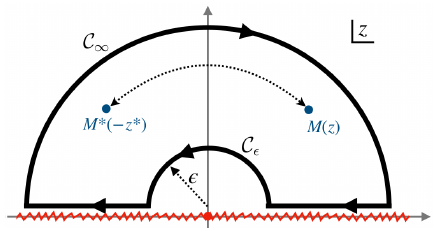
Figure 1 . Contour of integration used to relate (2.13) with